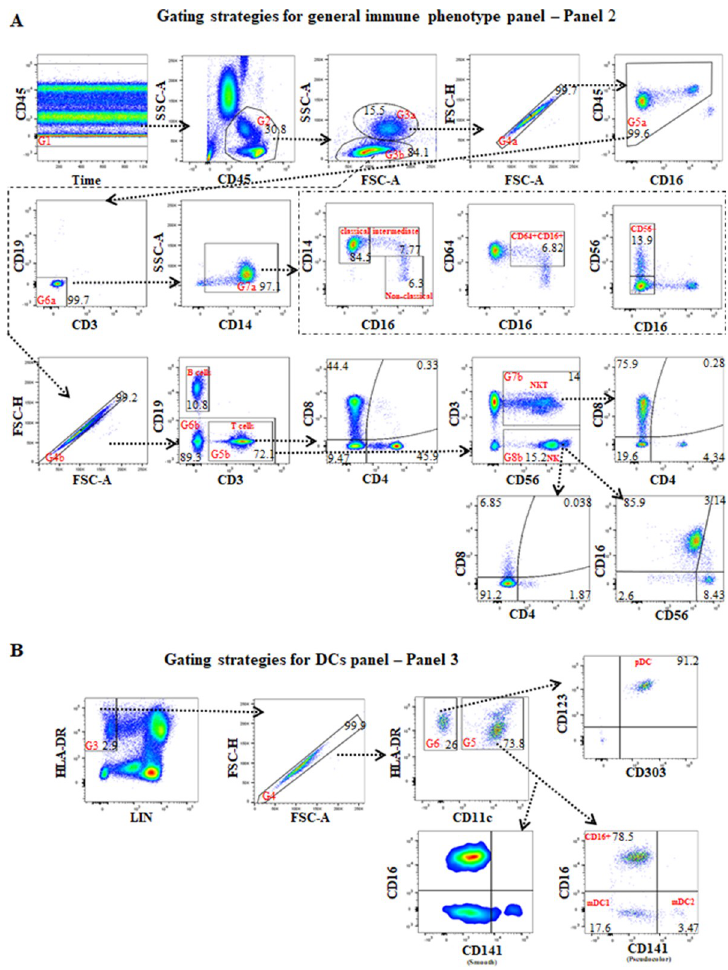
Fig 3. The gating strategies for the general immune phenotype panel (panel 2) and the DC panel (panel 3). (A) For panel 2, the first gate (G1) is on time vs CD45 to exclude poor flow, the second gate (G2) is on CD45 vs SSC-A to exclude granulocytes, the third gate (G3) is on FSC-A vs SSC-A for separating monocytes, including DCs (G3a), and lymphocytes (G3b). Under G3a is G4a which is on FCS-A vs FSC-H to exclude double-cells, G5a is on CD16 vs CD45 to exclude granulocytes again, G6a is on CD3 vs CD19 to exclude T and B cells, G7a is on CD14 vs SSC-A for CD14 +monocytes, with further assessment of classical (CD14+brightCD16-), intermediate (CD14+brightCD16+), non- classical (CD14+dimCD16+bright); CD16+CD64+(CD16 vs CD64); and CD56+CD16- (CD16 vs CD56) monocytes. Under G3b is G4b which is on FCS-A vs FSC-H to exclude double-cells on lymphocyte. CD3 vs CD19 under G4b is for B and T cells populations. Gating on CD3+ T cells (G5b) was done to further assess CD4+, CD8+, CD4-CD8- and CD4+CD8+ subsets (CD4 vs CD8); gating on CD19- cells (G6b) was undertaken to assess CD3+CD56+ NKT cells and CD56+ NK cells (CD56 vs CD3); gating on CD3+CD56+ NKT (G7b) was done for assessment of CD4 vs CD8 subsets of NKT cells. Gating on CD56+ NK in gate G8b further assessment of CD16+CD56+, CD16+CD56+bright (intermediate), CD16-CD56+bright and CD16-CD56+ NK subsets (CD56 vs CD16), and CD4+, CD8+, and CD4-CD8- NK subsets (CD4 vs CD8) was undertaken. (B) The gating strategies for the DC panel (panel 3). The first and second gates were the same as in panel 2. Gating on HLA-DR+LIN- (CD3CD14CD19CD20CD56) in gate G3 (LIN vs HLA-DR) was performed to exclude CD14+ monocytes, CD3+ T, CD19+ and CD20+ B, CD56+ NK cells, then the fourth gate (G4) was performed to exclude double-cells. Gating on CD11c+HLA-DR+ cells in gate G5 was performed to assess CD141+mid/bright mDC2, CD141- mDC1 and CD16+ DCs (pseudocolor and smooth of CD141 vs CD16); and gating on CD11c-HLA-DR+ cells (G6) was undertaken to assess plasmacytoid DCs CD303+CD123+ (pDCs) and CD303-CD123-/dim HLA-DR+ immature cells (CD303 vs CD123). are listed in Table 1. For example, the SSM of APC-R700-CD64 to PE-Cy7-CD14 in panels 2 was 3.01 (S4 Table). In this panel, we gated on CD14, then assessed the proportion of CD16